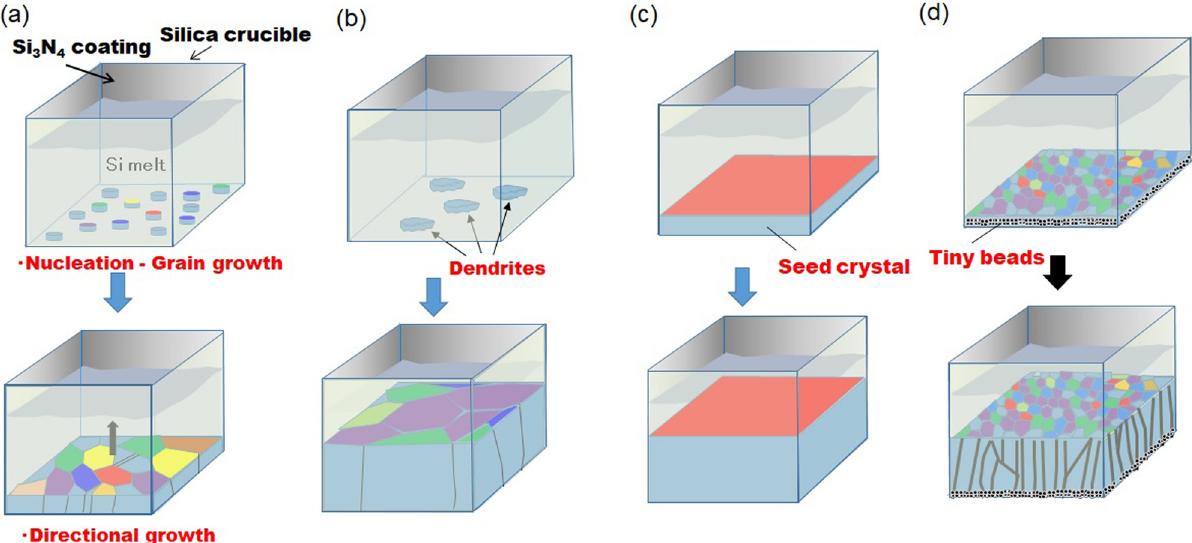
Figure 1: Directional solidi fi cation processes in various methods for producing mc - Si ingots for solar cells: ( a ) conventional directional solidi fi cation method, ( b ) dendritic casting method, where dendrite growth is promoted along the bottom wall of the crucible to create a grain structure with large grains, ( c ) mono casting method, where a single crystal is preset on the bottom wall of the crucible to grow a single crystal ingot in the crucible, and ( d ) HP mc - Si growth, where tiny beads are preset on the bottom wall of the crucible to enhance nucleation to obtain a grain structure with small